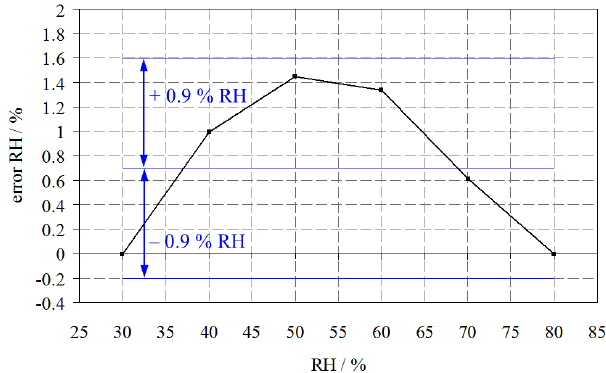
Figure 11. Error of the relative humidity using a two-point calibra- tion at 30%RH / 25 ◦ C and 80%RH / 25 ◦ C. To get a high absolute accuracy over the whole range, a typical offset of 0.7%RH needs to be subtracted from the original linear interpolation data. The maxi- mum error of the four sensors is then ± 0.9%RH.